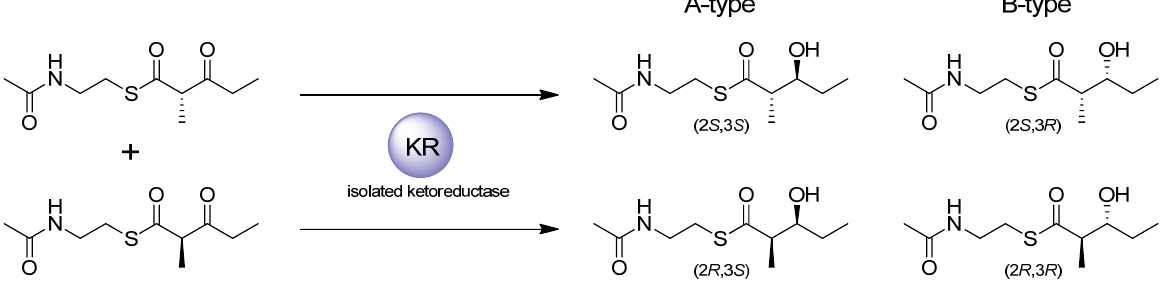
Figure 9. Reduction of surrogate substrates by recombinant KR domains isolated from their parent PKSs